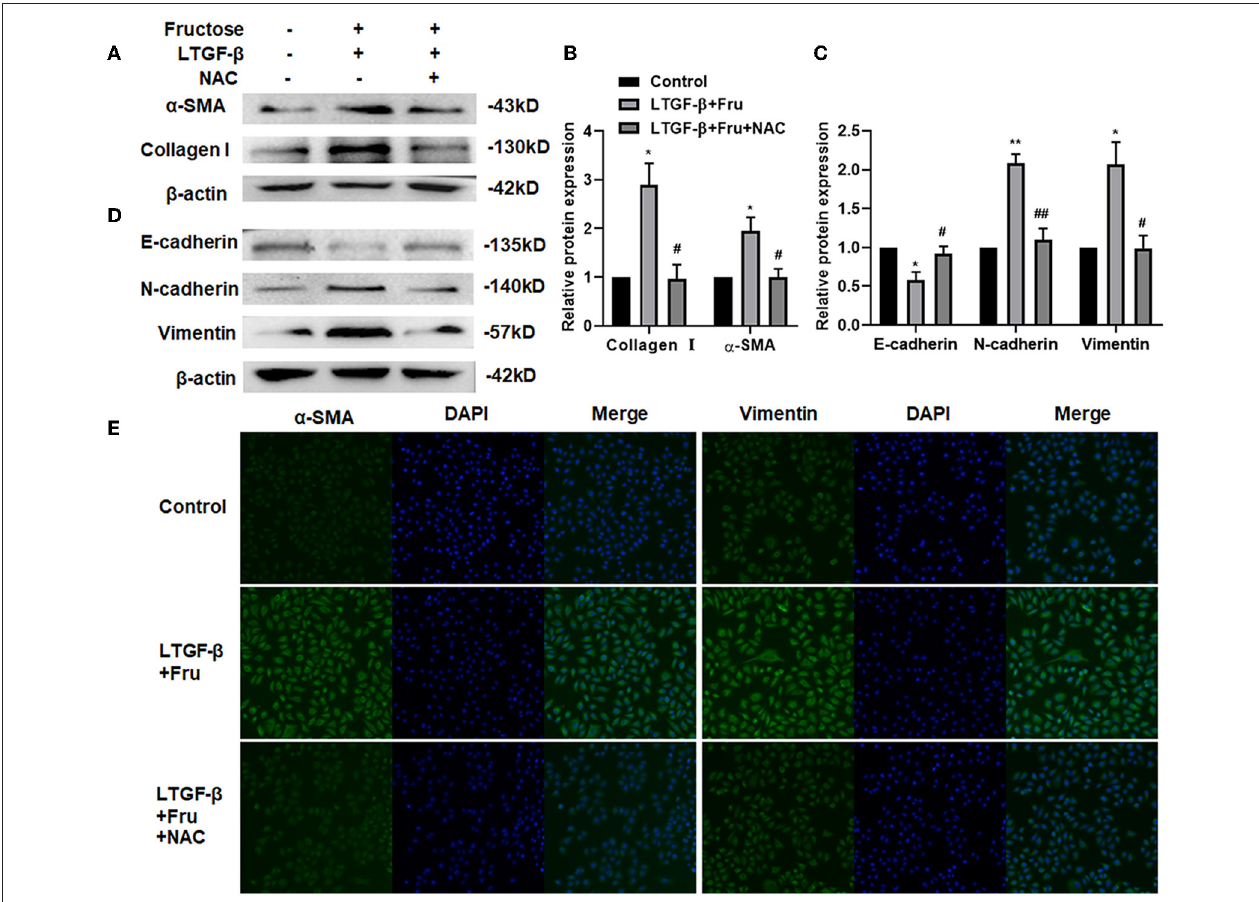
FIGURE 6 | Effect of NAC scavenging fructose-induced ROS on the fibrosis and EMT process of A549 cells treated by latent TGF- β 1. A549 cells were treated under the indicated treatment for 24h, and then the expression of fibrosis-related proteins (A and B) (Collagen 1 and α -SMA) and EMT-related proteins (C and D) (N-cadherin, E-cadherin, and Vimentin) were assessed by Western blot. Data are expressed as the Mean ± S.E.M ( n = 3) and analyzed using one-way ANOVA followed by Tukey’s test. The relative value was set as fold induction to that of the control set at 1, normalized to β -actin. * p < 0.05 and ** p < 0.01 vs. control group; # p < 0.05, ## p < 0.01, compared with the LTGF- β 1 + Fru group. Additionally, the vimentin or α -SMA expression was determined by immunofluorescence (200 × ). (E) Control, 0mM fructose; Fru, 10mM fructose; LTGF- β 1 + Fru, latent TGF- β 1 + 10mM fructose; NAC,